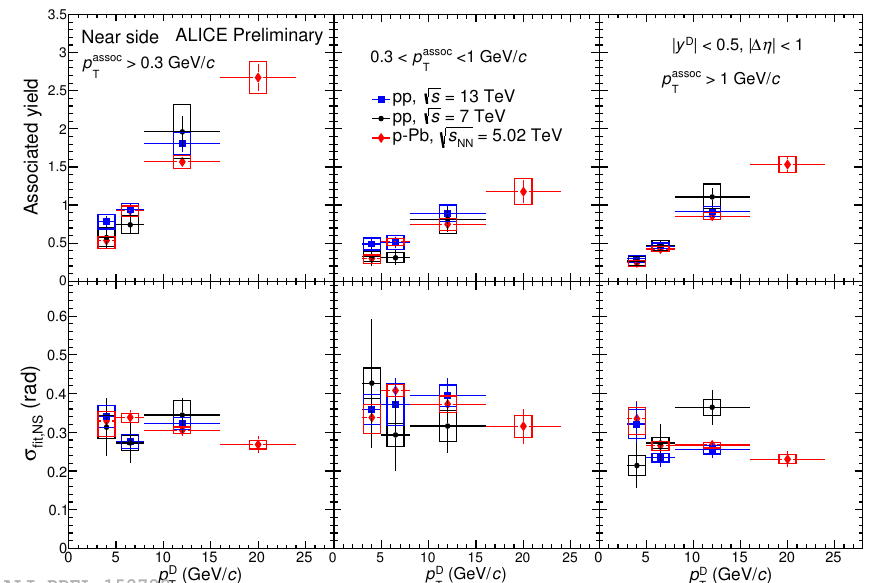
√ s = 7,13 TeV and p-Pb